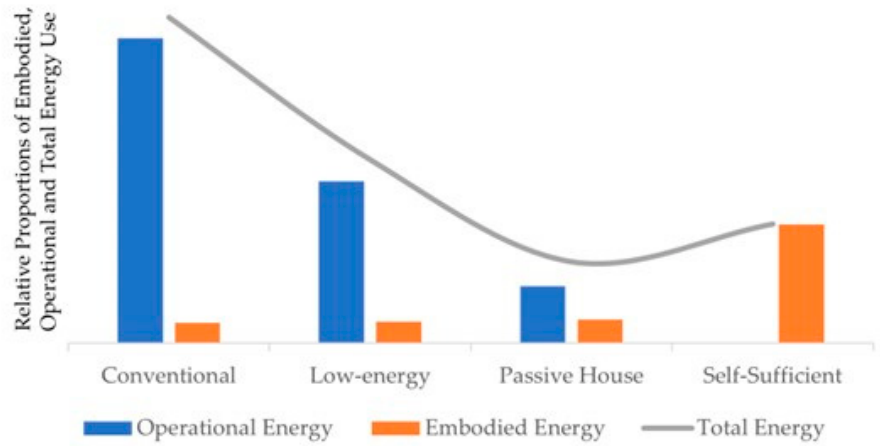
Figure 1. Relative Proportions of Embodied, Operational, and Total Energy Use in Conventional, Low-Energy, and Zero Energy Buildings [13].